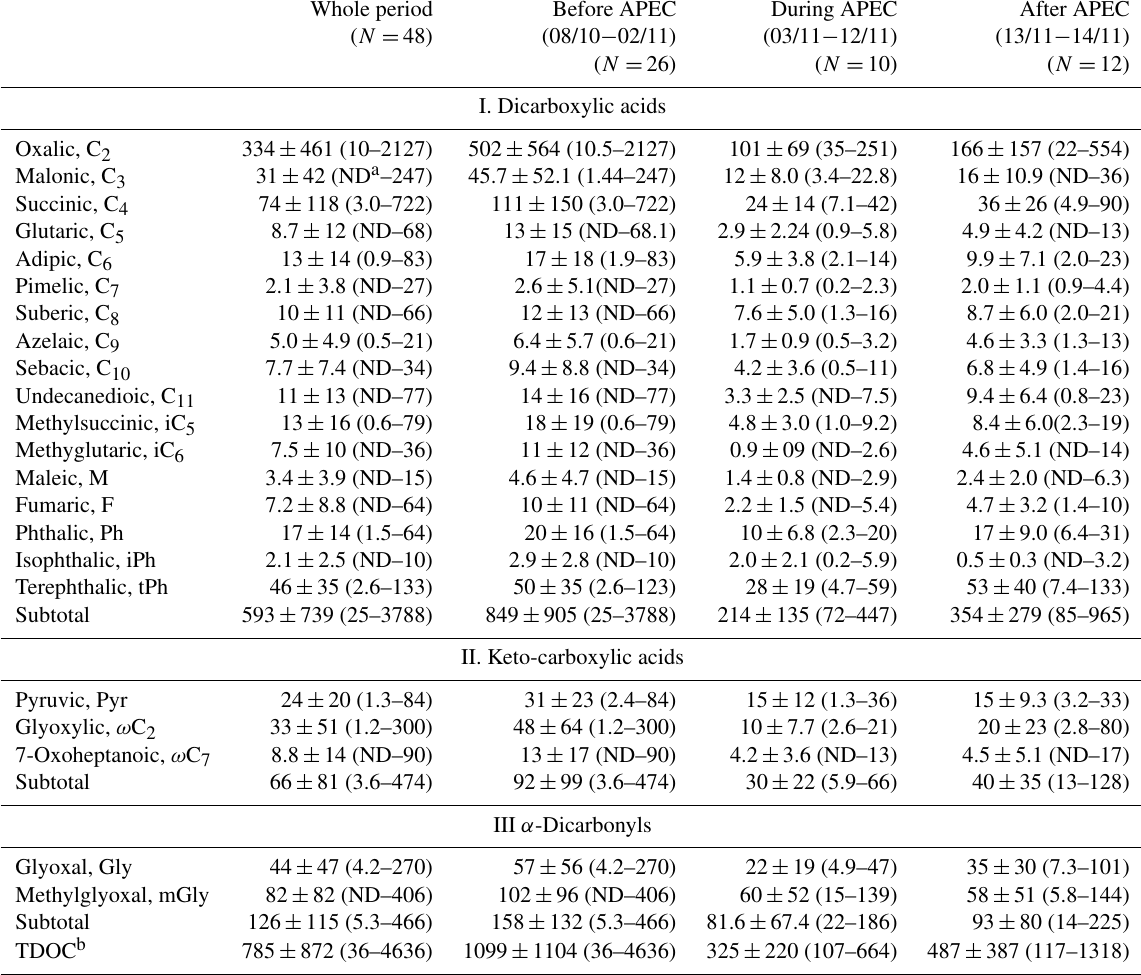
Table 2. Concentrations of dicarboxylic acids and related compounds in PM 2 . 5 in Beijing during the 2014 APEC campaign (ngm − 3 ) . Whole period Before APEC During APEC After